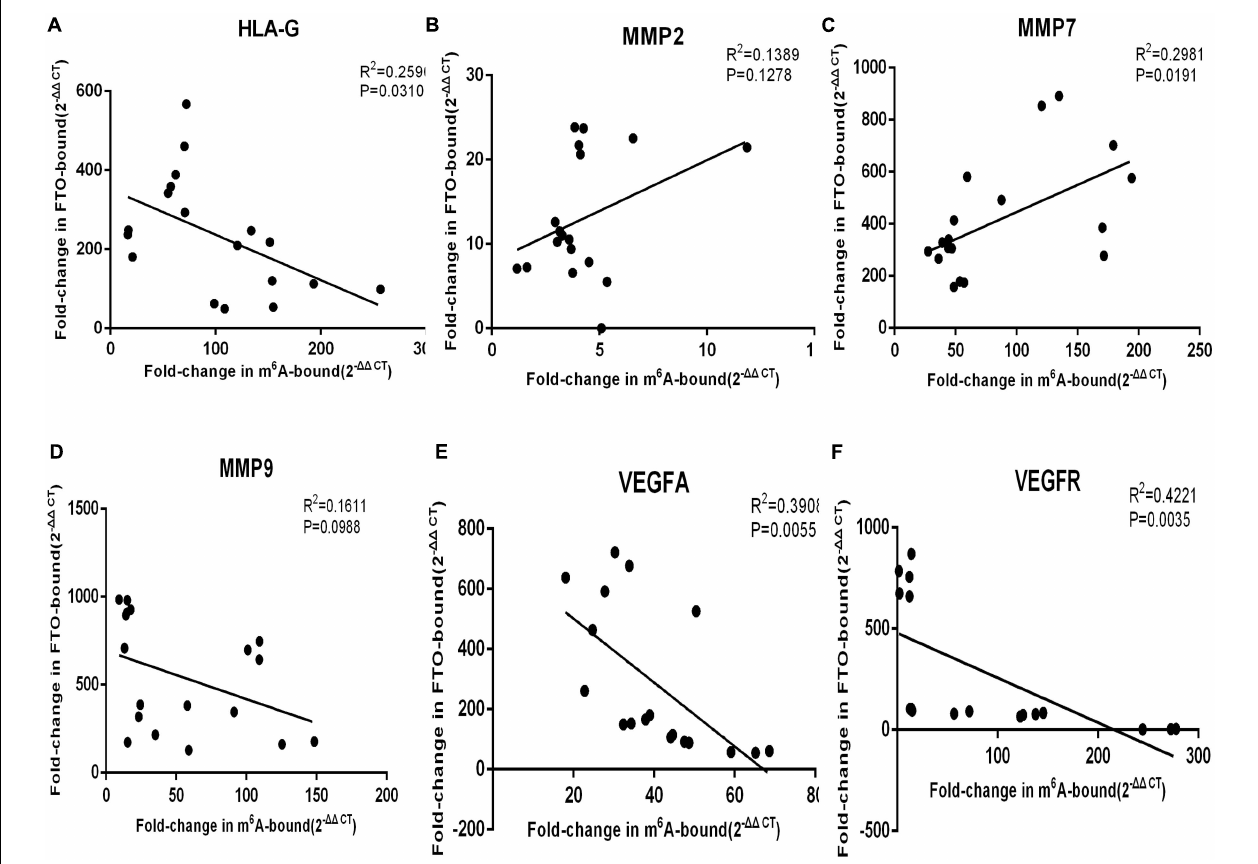
FIGURE 8 | The levels of FTO-bound (A) HLA-G , (B) MMP2 , (C) MMP7 , (D) MMP9 , (E) VEGFA , and (F) VEGFR mRNA was correlated to these mRNA with m 6 A